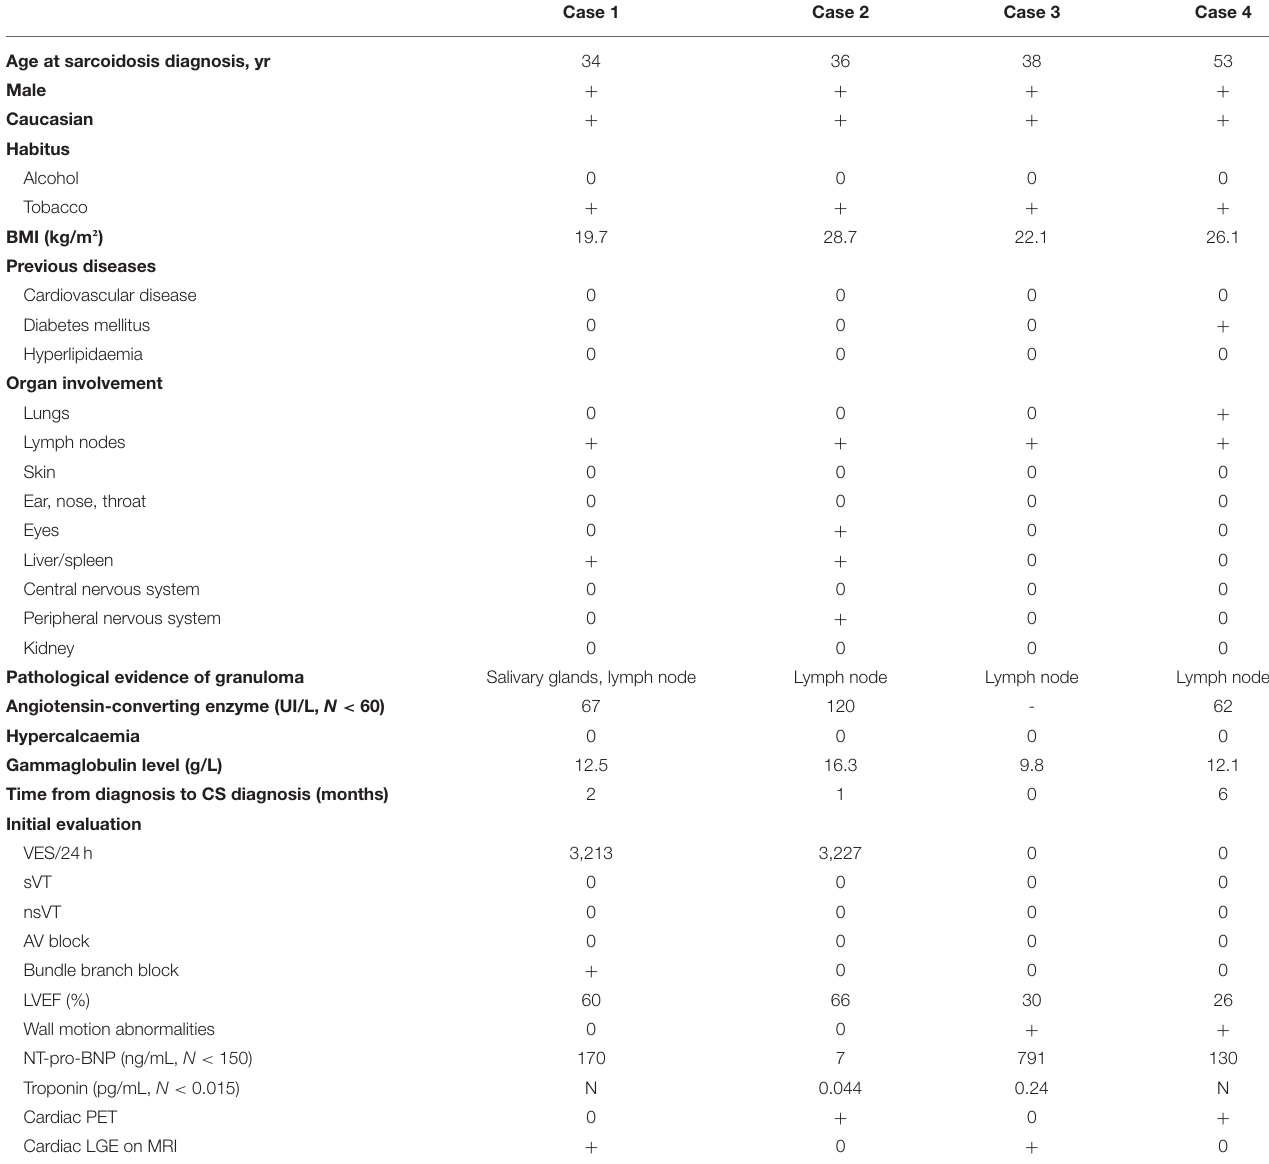
TABLE 1 | Baseline characteristics of patients in our case